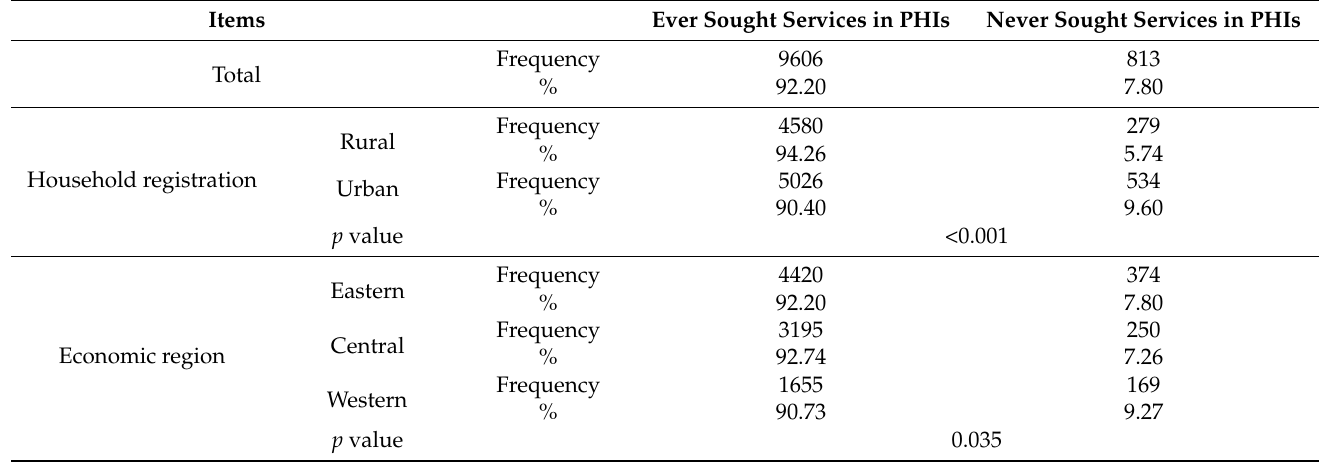
Table 2. Health services seeking in PHIs among